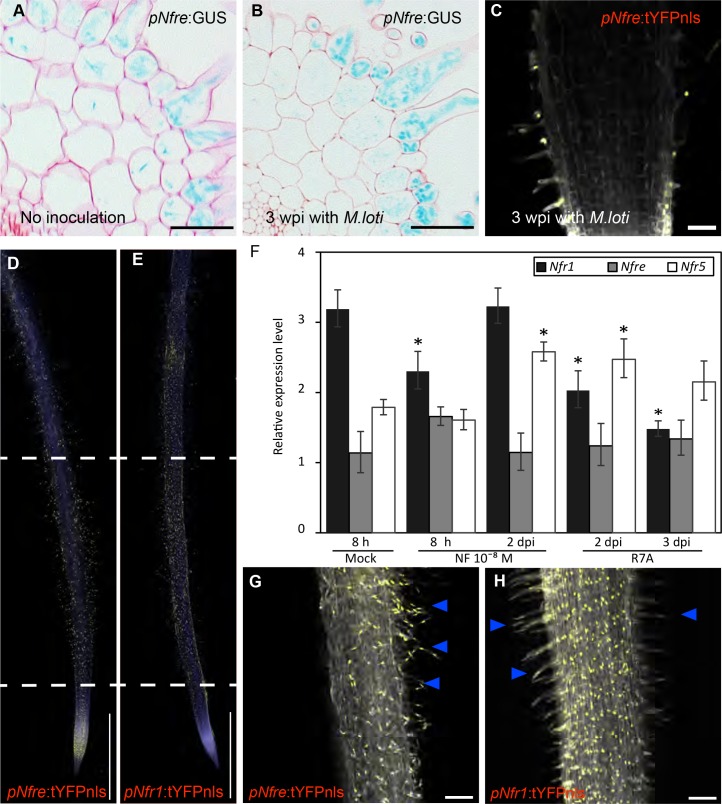
Expression patterns of LysM receptors in Lotus japonicus.(A) The expression of Nfre:GUS in hairy root of WT without Rhizobium inoculation. (B) The expression of pNfre:GUS in hairy root of WT at 3 weeks after inoculation with M.loti (C) The expression of pNfre:tYFPnls is maintained in the root hairs at 3 weeks after inoculation with M.loti. (D) The epidermal cells, primarily localized in the root susceptible zone, show activity of the Nfre promoter visualized by the nuclear localized triple YFP protein (tYFPnls). (E) Widespread activity of the Nfr1 promoter in the uninoculated root visualized by nuclear localized triple YFP protein (tYFPnls). (F) Transcript levels of Nod factor receptors measured by quantitative RT-PCR in Mock (water)-treated, Nod factor-treated or M. loti inoculated wild type roots. Relative expression levels of the three receptors in three biological and three technical replicas are shown. The levels of housekeeping genes, ATP, UBC and PP2A were used for calculating the relative expressions. *p<0.05, Student´s t-test compared with the expression level in Mock (water)-treated samples. (G) The epidermal cells (root hairs- arrows) of 3dpi root show activity of the Nfre promoter (Nfre:tYFPnls). (H) The epidermal cells (root hairs- arrows) of 3dpi root show lower activity of the Nfr1 promoter (Nfr1:tYFPnls) when compared to the rest of cortical cells or with Nfre in (G). Scale bars, 40 µm (A, B), 50 µm (C), 1 mm (d, e), 100 µm (G, H).